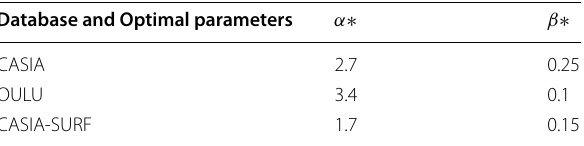
Table 3 Database and optimal parameter values for various databases, based on the tuning procedure Database and Optimal